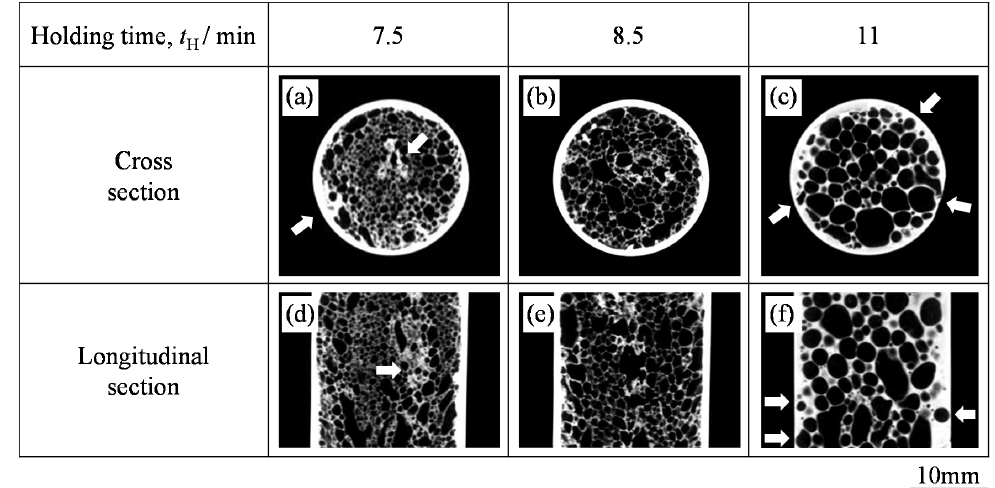
Figure 5. Cross ‐ sectional and longitudinal ‐ sectional X ‐ ray CT images of fabricated ADC12 ‐ foam ‐ filled A1050 tube samples with ( a , d ) t H = 7.5 min, ( b , e ) t H = 8.5 min, and ( c , f ) t H = 11 min.